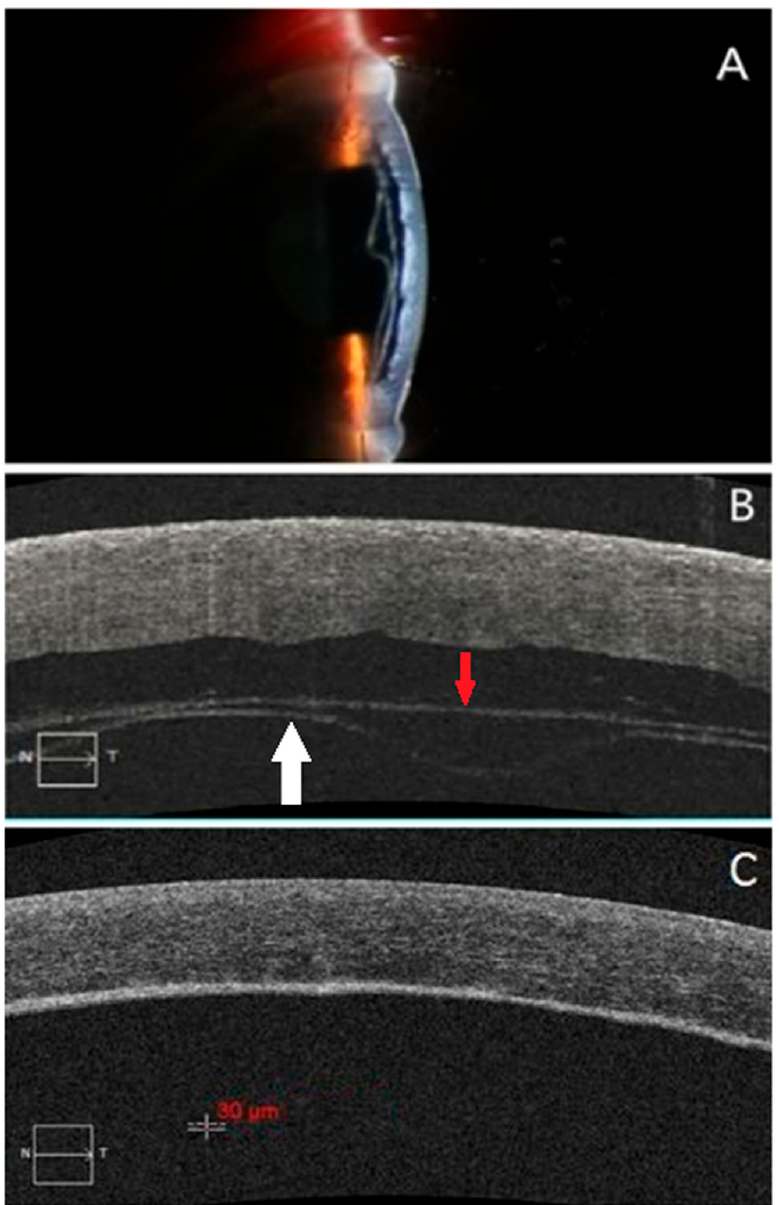
Figure 1. The boundary between the corneal stroma and EDM in HD-OCT images are unclear after DM reattachment in pdDALK patients. ( A ): One case of a 59-year-old male with fungal keratitis and underwent pdDALK in his left eye, triple chamber was observed on the first post-operative day. ( B ): The HD-OCT image shows the graft separated from the residual stromal bed, and the EDM layer (white arrow) was detached from the stroma (red arrow). The patient underwent the interface drainage along with descemetopexy. ( C ): 3 months later the HD-OCT image shows that the grayscale boundary between the graft and the residual stromal bed was clear, but there was no obvious boundary between the residual stroma and EDM layer which is difficult to measure the EDM